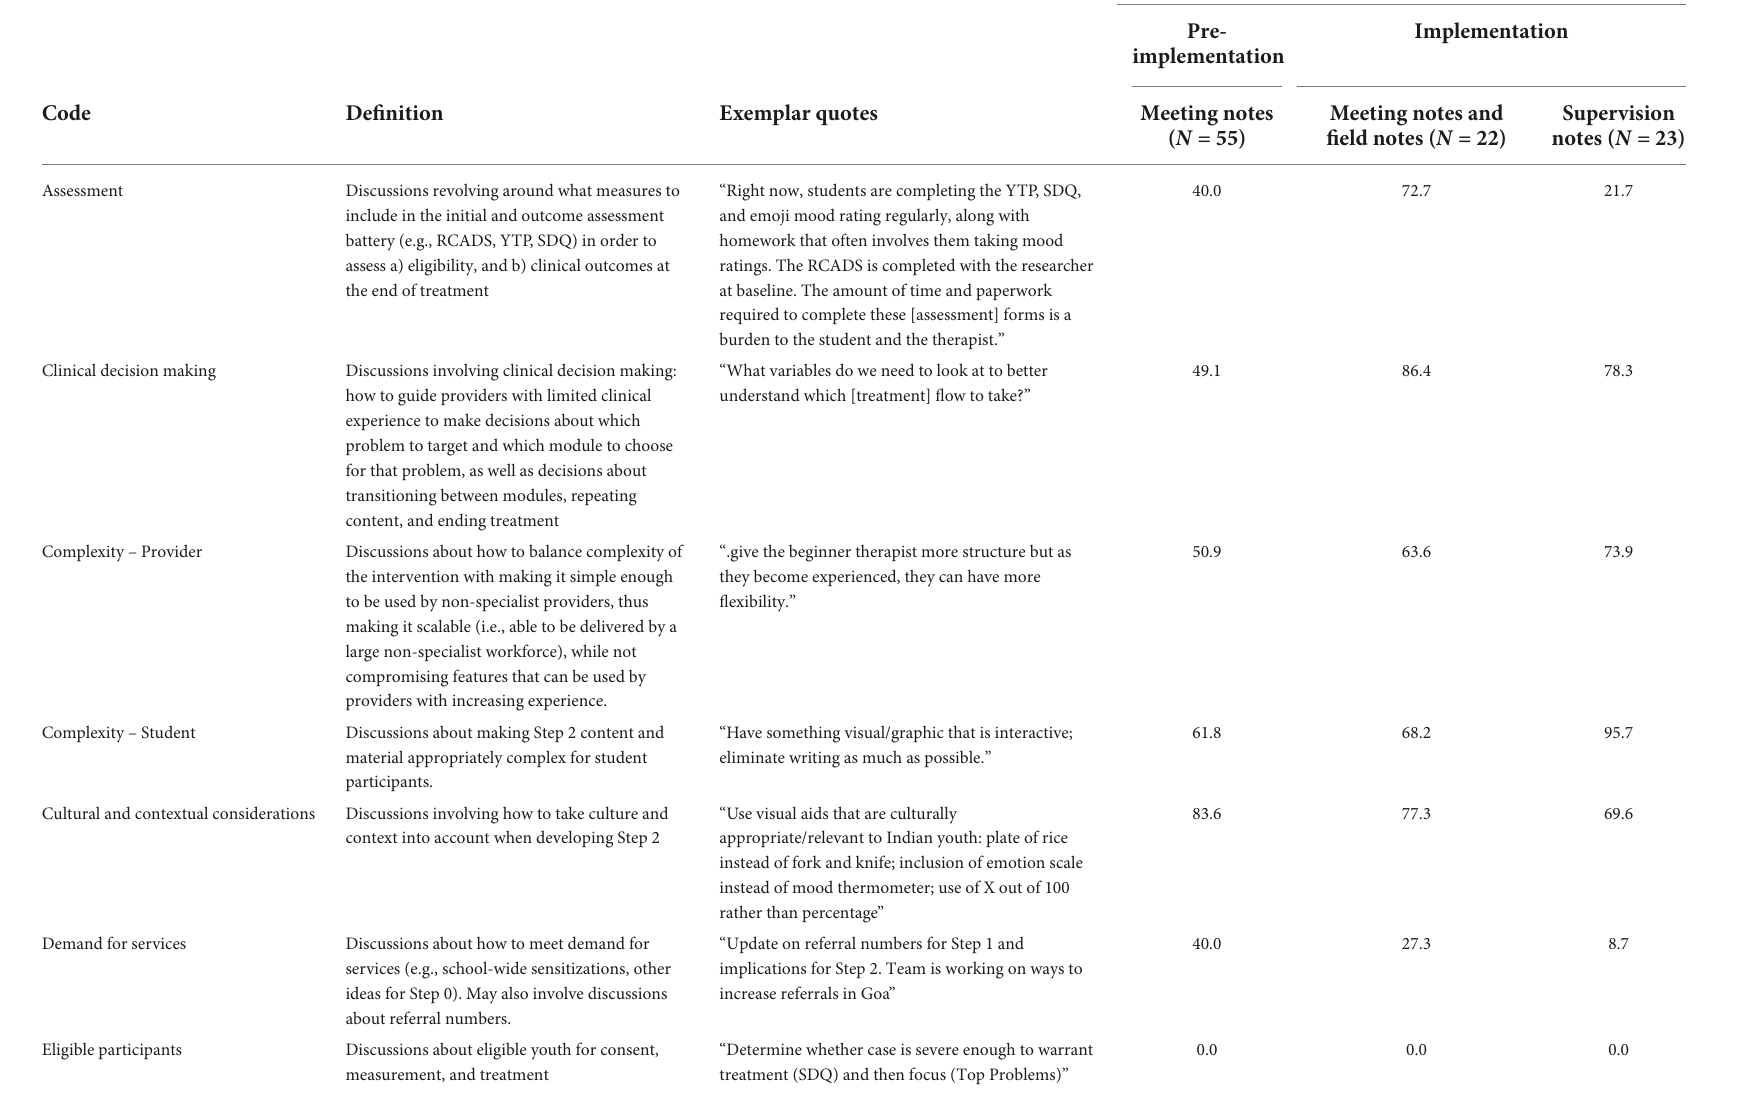
TABLE 1 Presence of codes applied to notes in pre-implementation phase and implementation